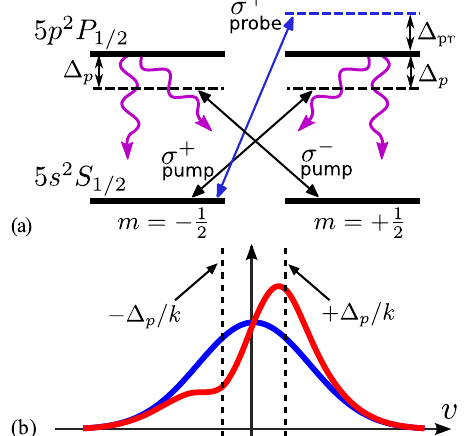
FIG. 1. (a) Optical pumping and LIF spectroscopy. Ions are optically pumped from the þ 1 = 2 to − 1 = 2 electronic spin state around v x ¼ − Δ p =k , andfrom the − 1 = 2 to þ 1 = 2 spinstate around v Δ =k with two counterpropagating, circularly polarized x ¼ þ p laser beams detuned by − Δ p rad = s from the 2 S 1 = 2 − 2 P 1 = 2 tran- sition of the strontium ion (421.7 nm). The velocity profiles of the individual spin populations are measured with LIF using a tunable circularly polarized probe beam of variable detuning Δ (b) Idealized illustration of a pumped velocity distribution for þ 1 = 2 ions resulting from optical pumping (red curve), along with an unperturbed Gaussian thermal distribution (blue